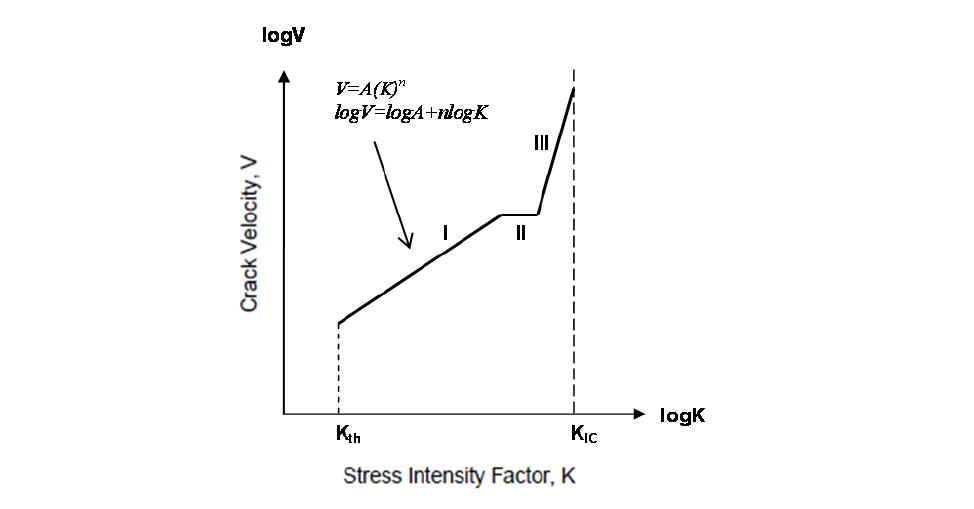
Figure 1: Regions of a typical log V versus log K